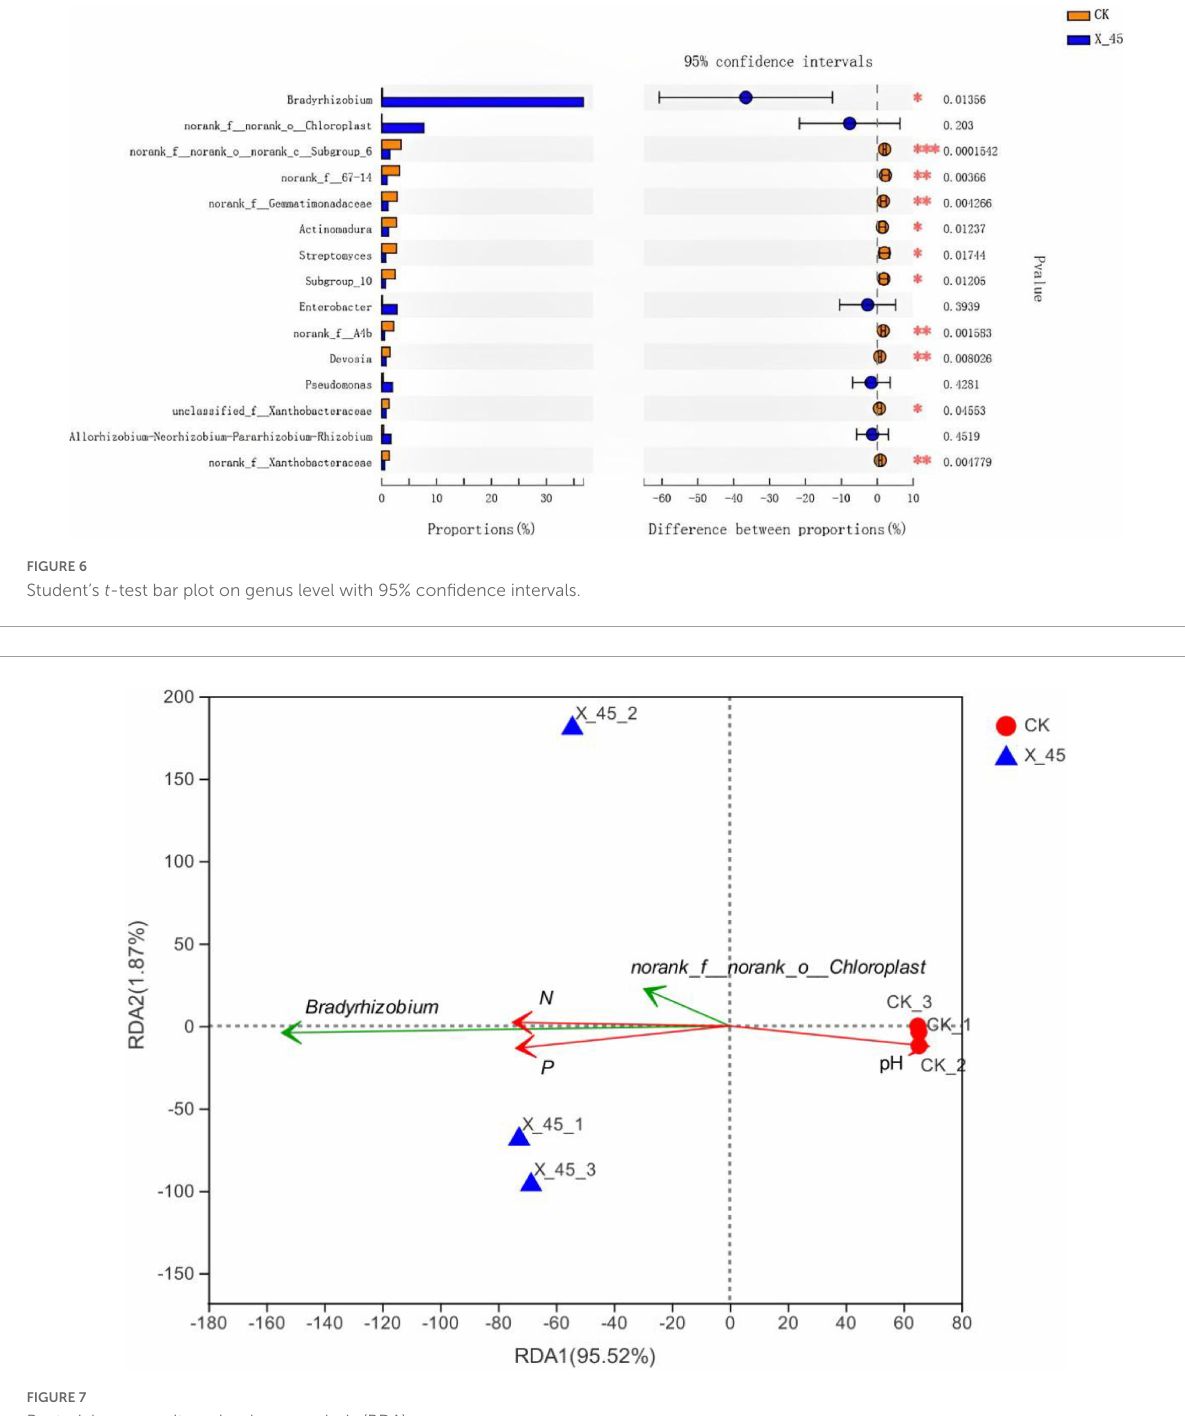
FIGURE7 Bacterial community redundancy analysis